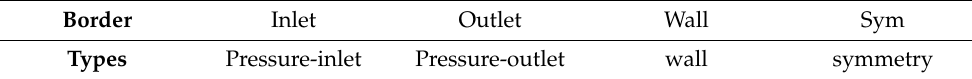
Table 3. Setting of boundary conditions in numerical simulation model of nozzle.